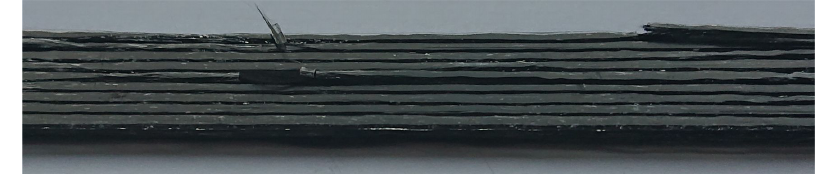
Figure 10. CFRP structure after the tensile